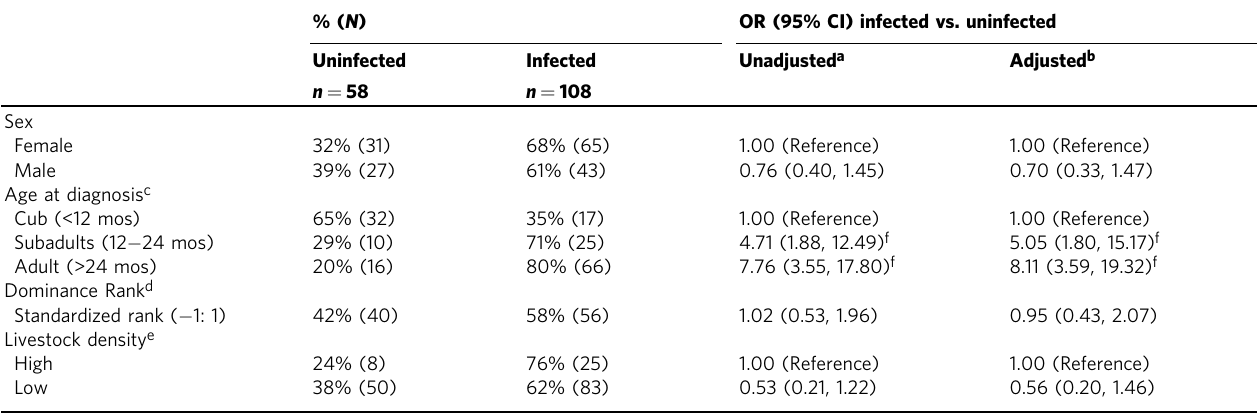
Table 1 Prevalence of T. gondii infection among 166 spotted hyenas from the Masai Mara, Kenya, and its relationship to demographic, social, and ecological